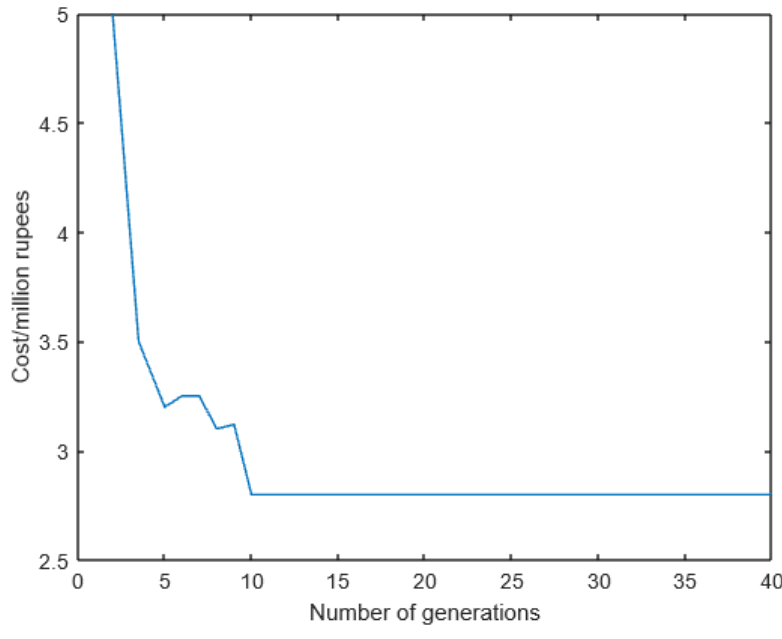
Figure 14. GA-based optimal